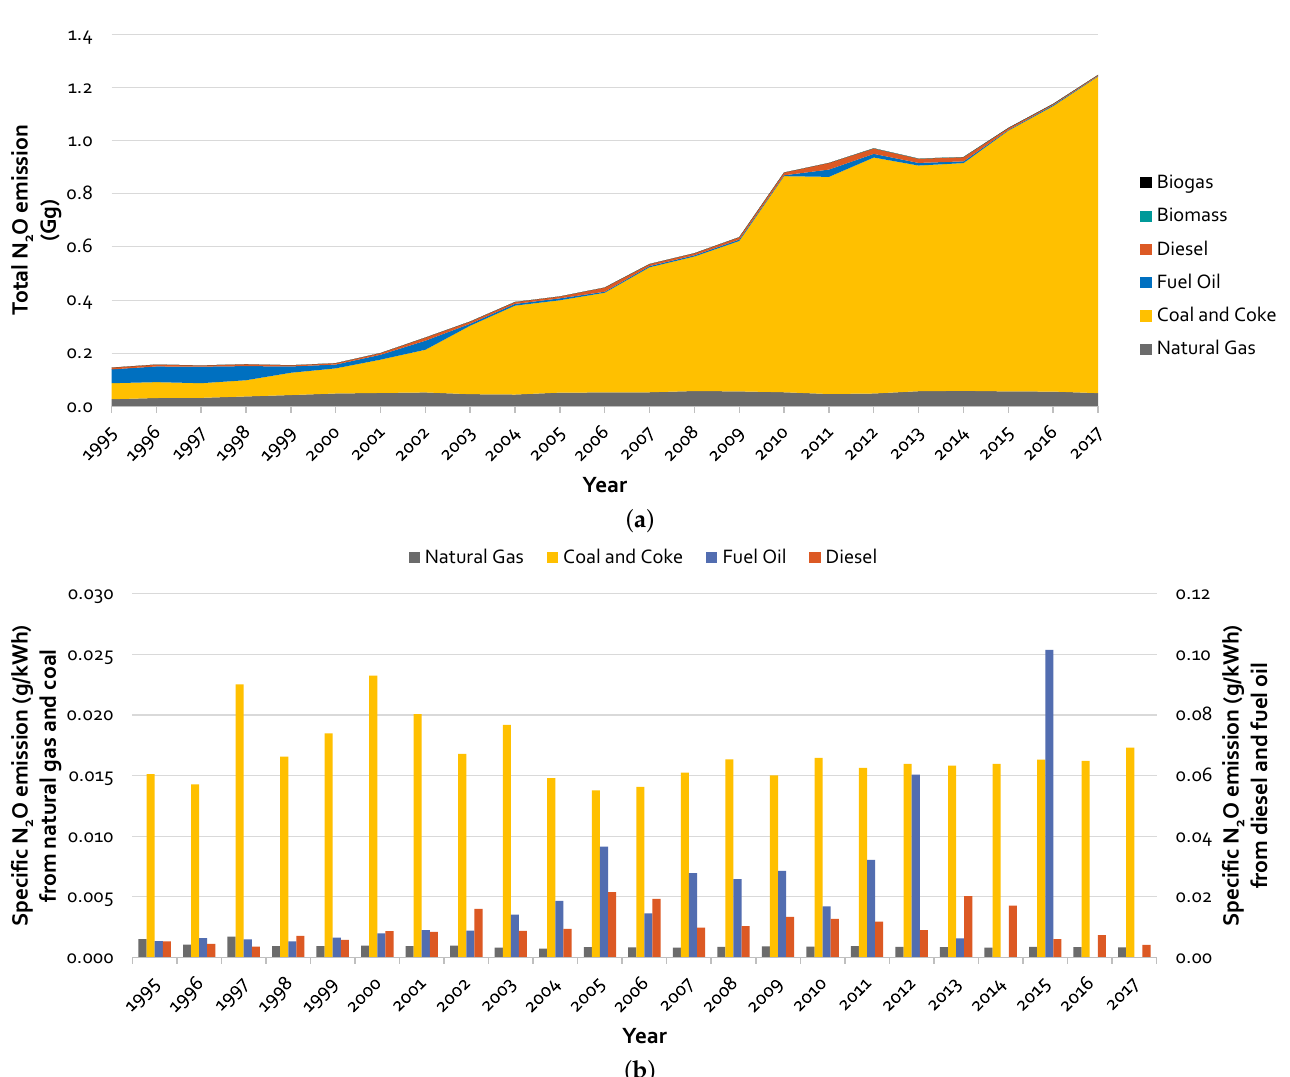
Figure 13. ( a ) Total annual and ( b ) specific N 2 O emissions from Malaysia electricity generation sector from 1995 to